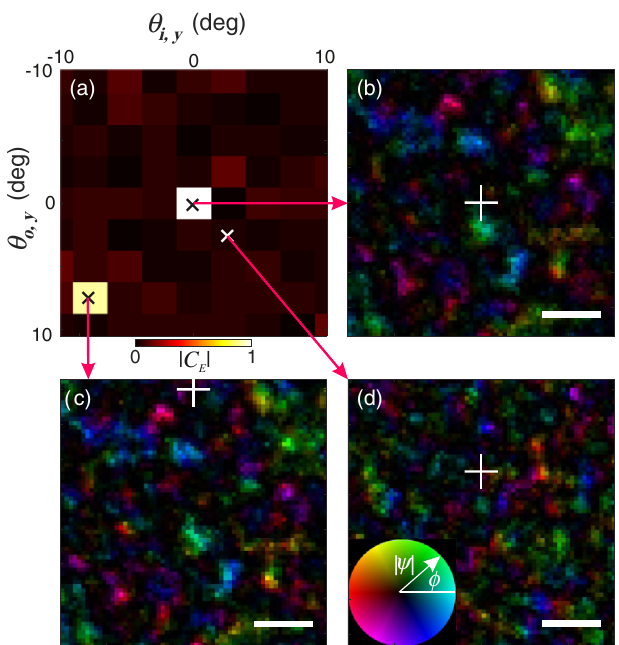
FIG. 2. Angular correlation of output field patterns. (a) Corre- lation coefficient j C E ð θ i;y ; θ o;y Þj for the incident wave front given ˜ θ by the eigenvector j V 1 i of the angular memory operator Q ð i;y ¼ − 7 . 8 ° ; ˜ θ 7 . 1 ° Þ with the largest eigenvalue amplitude j α o;y ¼ 1 j . The number of controlled input channels is N i ¼ 1024 , and the number of detected output channels is N o ¼ 4096 . (b) With the incident wave front j V 1 i , the transmitted field pattern in the far field is represented with the field amplitude by brightness and the phase by color using the color wheel in (d). The horizontal and vertical axes denote k o;x and k o;y , the components of the output wave vector in x and y directions, respectively. The white plus sign marks the origin: k o;x ¼ 0 , k o;y ¼ 0 . The scale bar represents k ¼ 0 . 05 ð 2 π = λ Þ . (c) When the input wave front tilts by θ i;y ¼ ˜ θ ˜ θ − 7 . 8 ° and the output by θ 7 . 1 °, the output field i;y ¼ o;y ¼ o;y ¼ pattern is highly correlated to the original one in (b), with ˜ θ j C E j ¼ 0 . 9 . (d) The transmitted field pattern for θ i;y ¼ 2 . 6 ° ≠ i;y ˜ θ and θ o;y ¼ 2 . 4 ° ≠ o;y is uncorrelated with that in (b), with j C E j ¼ 0 . 05 . The conventional angular-memory-effect range is about 1°. White plus signs in (c) and (d) represent the shift of the origin ( k o;x ¼ 0 ¼ k o;y ) of the transmitted field pattern. The scale bars are identical to that in (b). Amplitude and phase patterns in (b) and (c) are shown in separate panels in Fig. S2 of the Supplemental Material